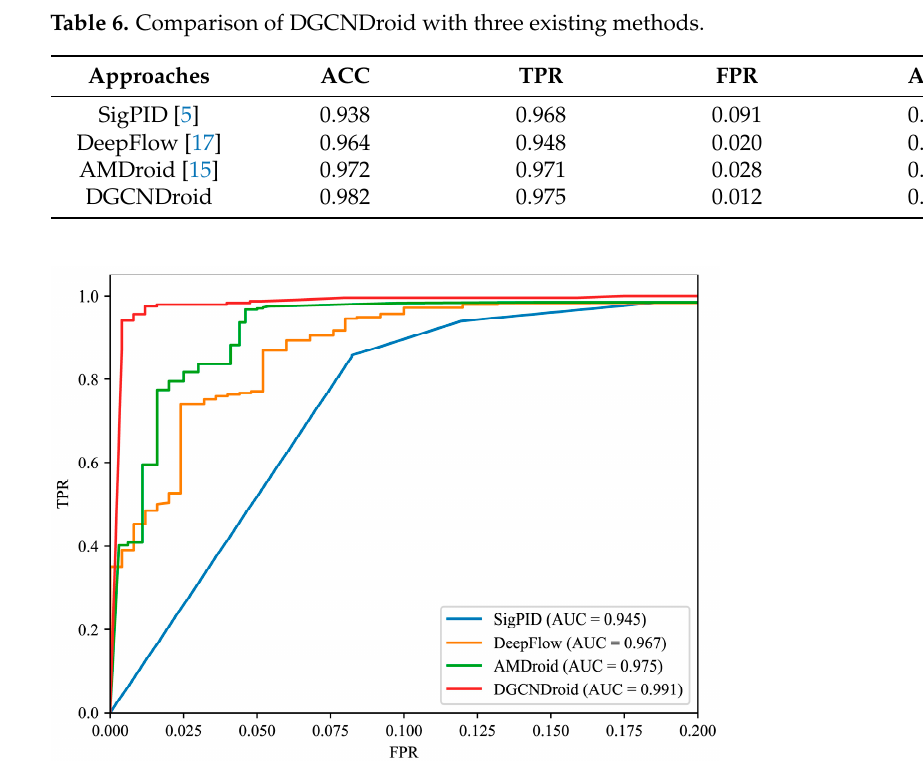
( b ) Figure 9. Comparison of function call graph structure of two malicious apps in SndApp family. In order to compare with the results of the malicious family classification methods in literature [14] and literature [35], we utilize the same Android Malware Genome Project